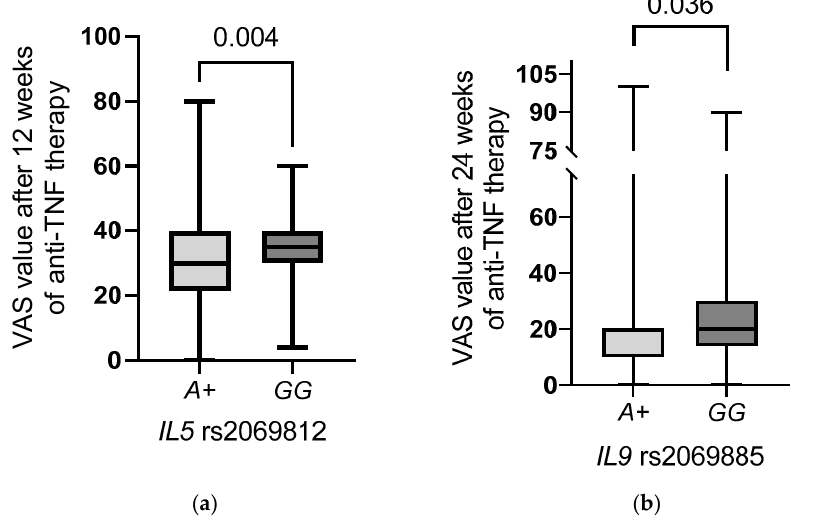
Figure 2. Relationships between the IL5 rs2069812 ( a ) and IL9 rs2069885 ( b ) polymorphisms and the VAS values in AS patients during anti-TNF treatment.